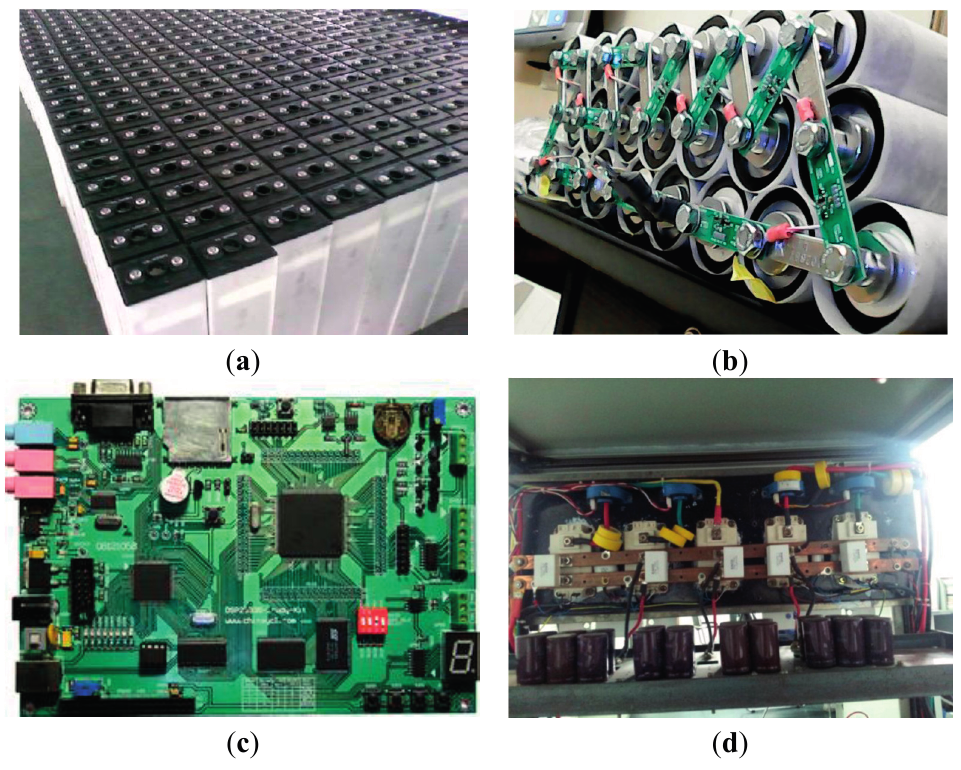
Figure 5. Hardware setup of the proposed scheme. ( a ) Batteries for testing; ( b ) Ultra-capacitors for energy storing system (ESS); ( c ) DSP control board; ( d ) AC–DC converter for utility dominating